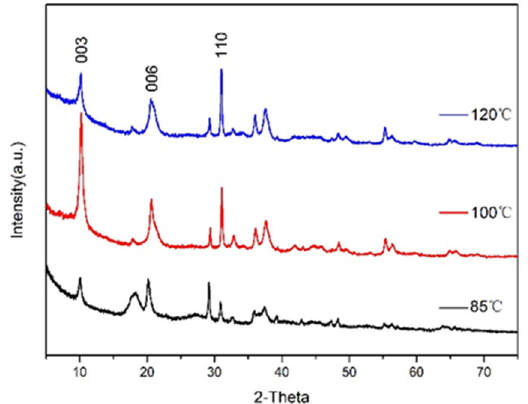
Figure 2. XRD patterns of CaAl–SiO 3 –LDHs prepared at different crystallisation temperatures.